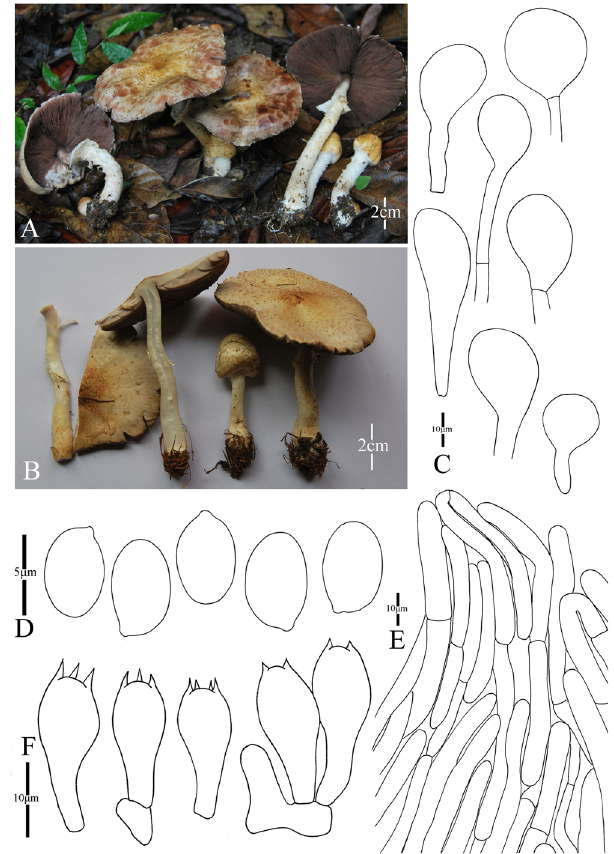
Figure 7. Morphology of Agaricus cerinupileus ( ZRL2012001 , holotype), ( A – B ): Basidiome in field ( A : ZRL2011157 ; ( B ): ZRL2012001 ), ( C ): Cheilocystidia, ( D ): Basidiospores, ( E ): Pileipellis hyphae, and ( F ):